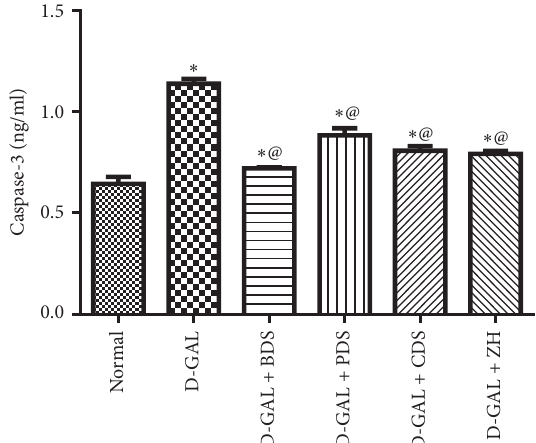
Figure 4: Effect of D. salina on hepatic content of caspase-3 in albino rats with age-related hepatic steatosis. Age-related hepatic steatosis was induced in rats by injections of D-galactose (200mg/kg I.P) for eight weeks. Rats injected with oral D-galactose for two weeks were treated with BDS (450mg/kg), PDS (30mg/kg), CDS (30mg/kg), or ZH (250 μ g/kg). Twenty-four hours later, the last dose of the treatment, rats were sacrificed and liver tissues were homogenized. Tissue homogenate were used for caspase assessment. Data are expressed as mean ± SEM from the normal value. Statistical analysis was performed by one-way analysis of variance (ANOVA) followed by the Tukey–Kramer test for multiple comparisons. ∗ Significantly different from the normal control group at P ≤ 0 . 05. @ Significantly different from D-galactose control at P ≤ 0 .